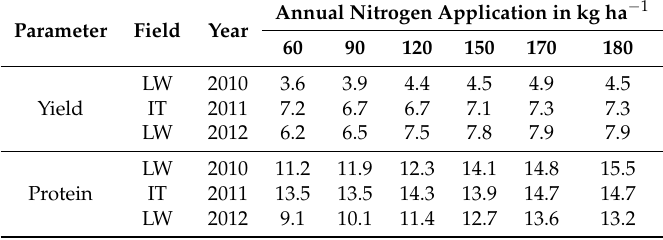
Table 3. Average grain yield (t ha − 1 ) and grain protein content (% in dry matter) of winter wheat ( Triticum aestivum L.) for six different N levels during three years of field experiment. “IT” marks the experimental field “Inneres Taele”, “LW” the experimental field “Lammwirt”. Both fields are located at Ihinger Hof, Renningen, Germany.